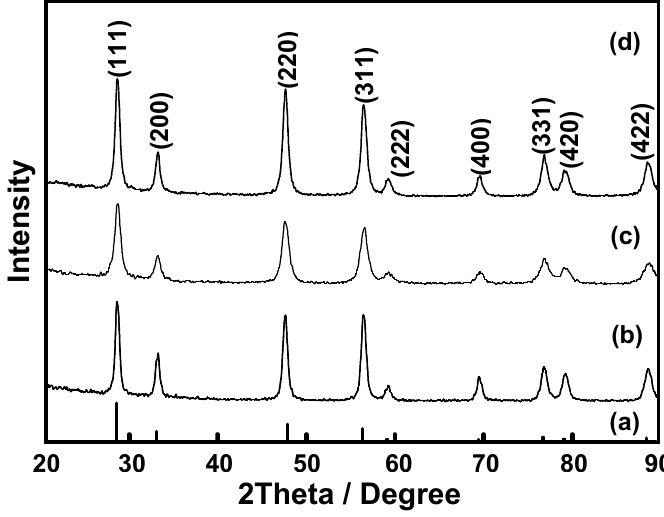
Table 2. The crystallite sizes of CeO determined by the application of the Scherrer equation. 2 Ce(III)-benzoxazine monomer complexes Crystallite size (nm)